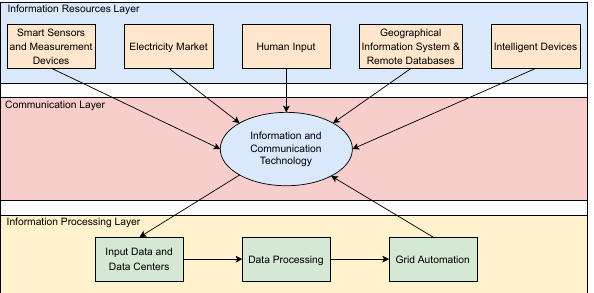
Figure 4. Three layers of information exchange and processing for grid automation.